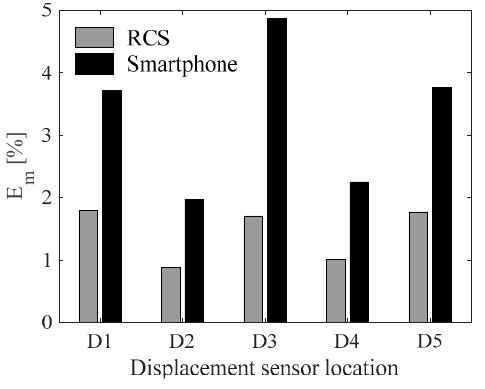
Figure 10 . The measurement error ( 𝐸 𝑚 ) between displacement sensors and cameras. Figure 10. The measurement error ( E m ) between displacement sensors and